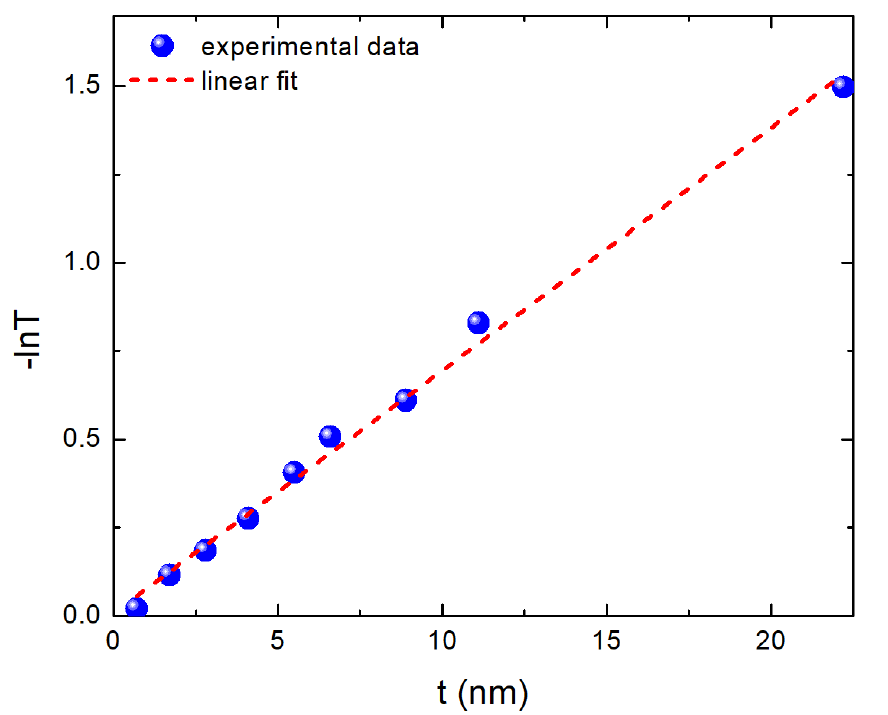
Figure 3. ( − lnT) as a function of film thickness t. The slope of the linear fit is equal to the absorption coefficient α at the second feature of the absorbance